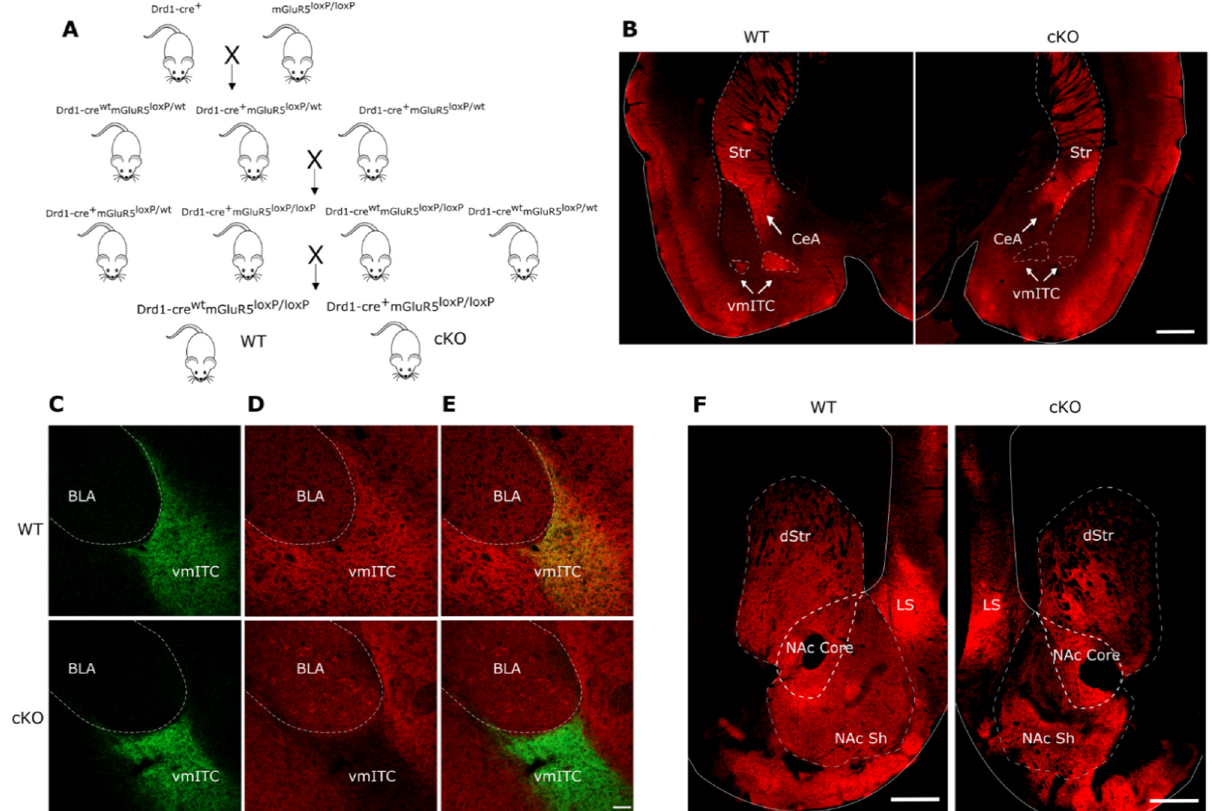
Figure 1. ( A ) Breeding strategy for the generation of mGluR5 D1 WT and cKO mice. ( B ) Example image of mGluR5 expression in the cortex, striatum, and amygdala of mGluR5 D1 WT (left panel) and cKO mice (right panel). Scale bar: 500 µ m. ( C ) Example image of D1 receptor expression (green) in the vmITC of mGluR5 D1 WT (top panels) and cKO mice (bottom panels), ( D ) mGluR5 expression (red), and ( E ) overlapped images. Scale bar: 40 µ m. ( F ) Example image of mGluR5 expression throughout the striatum and NAc of mGluR5 D1 WT (left panel) and cKO mice (right panel). Scale bar: 500 µ m. Area abbreviations: dorsal striatum (dStr), striatum (Str), lateral septum (LS), nucleus accumbens core (NAc core) and shell (NAc Sh), central amygdala (CeA), main nucleus of intercalated cells of the amygdala (vmITC), and basolateral amygdala (BLA).